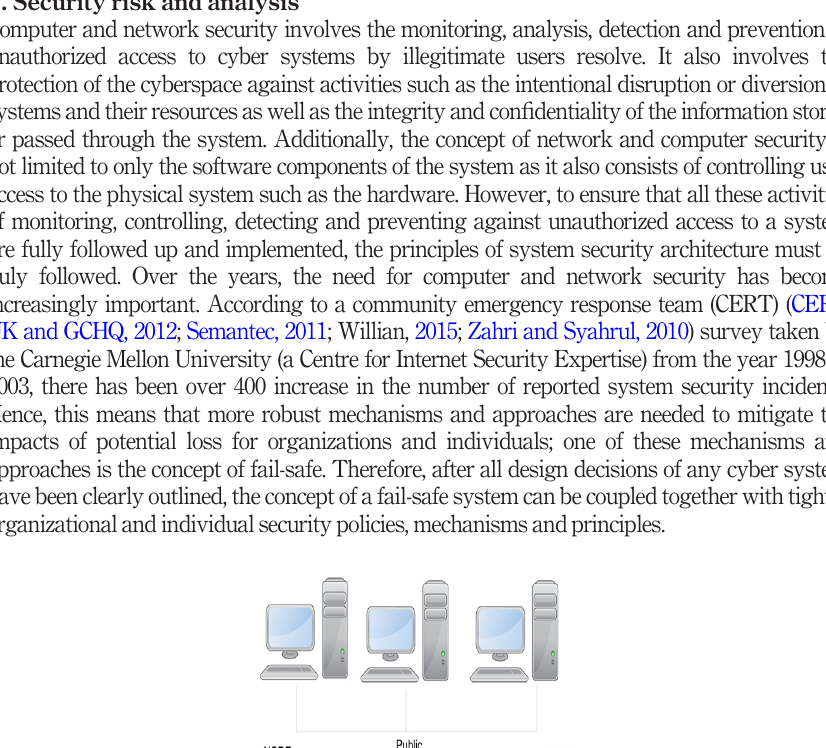
Figure 2. Architecture of